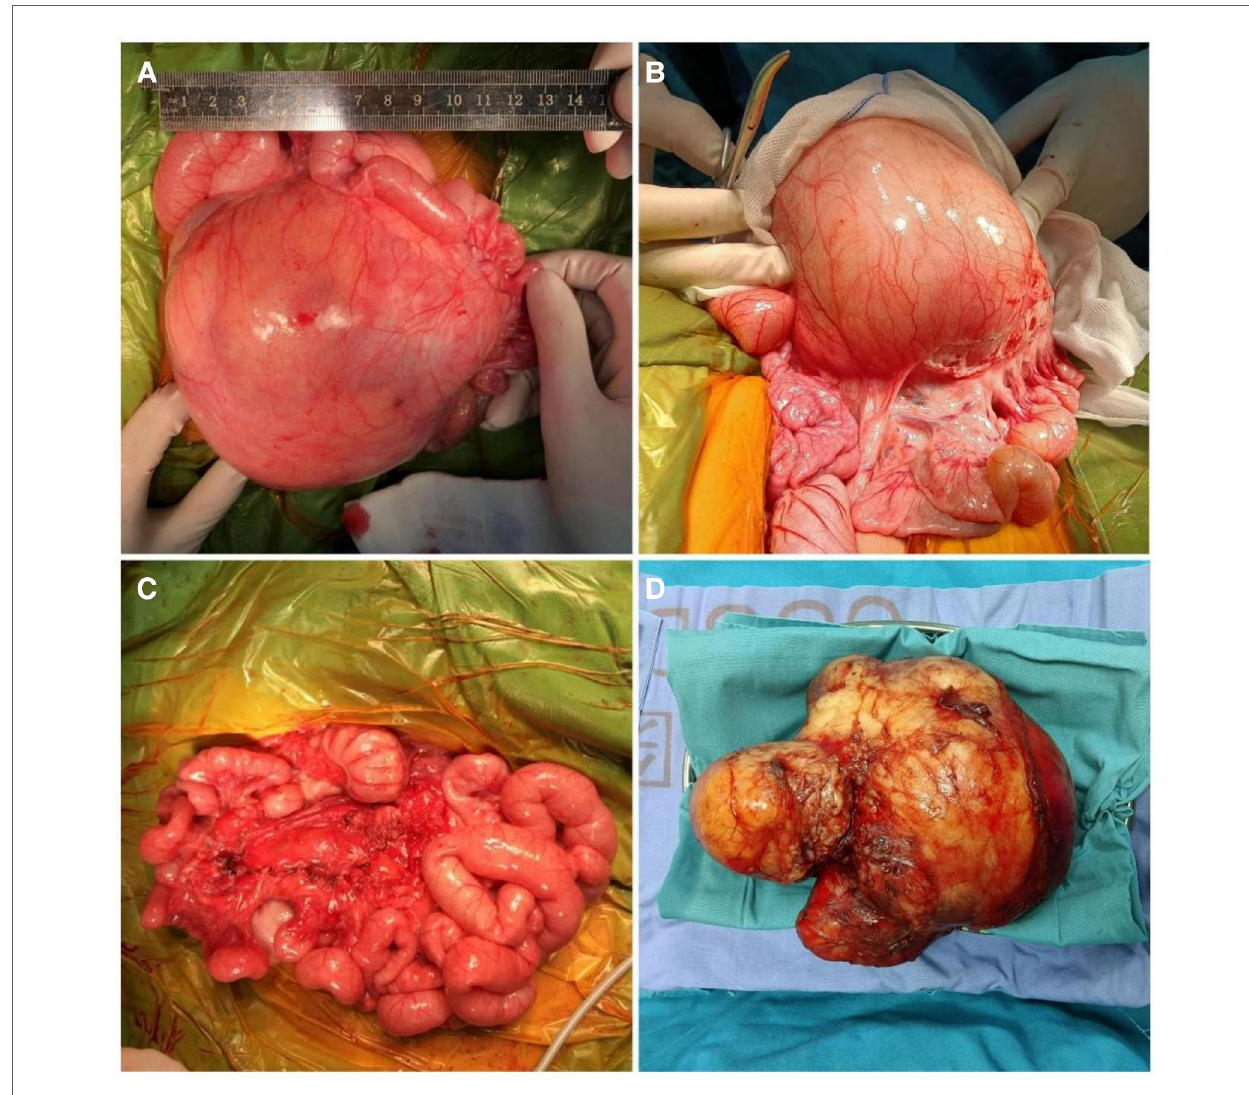
FIGURE 2 Pictures of a mass obtained during the operation. Pictures ( A , B ) show that the mass originated from the mesentery. Pictures ( C , D ) were taken after the mass was